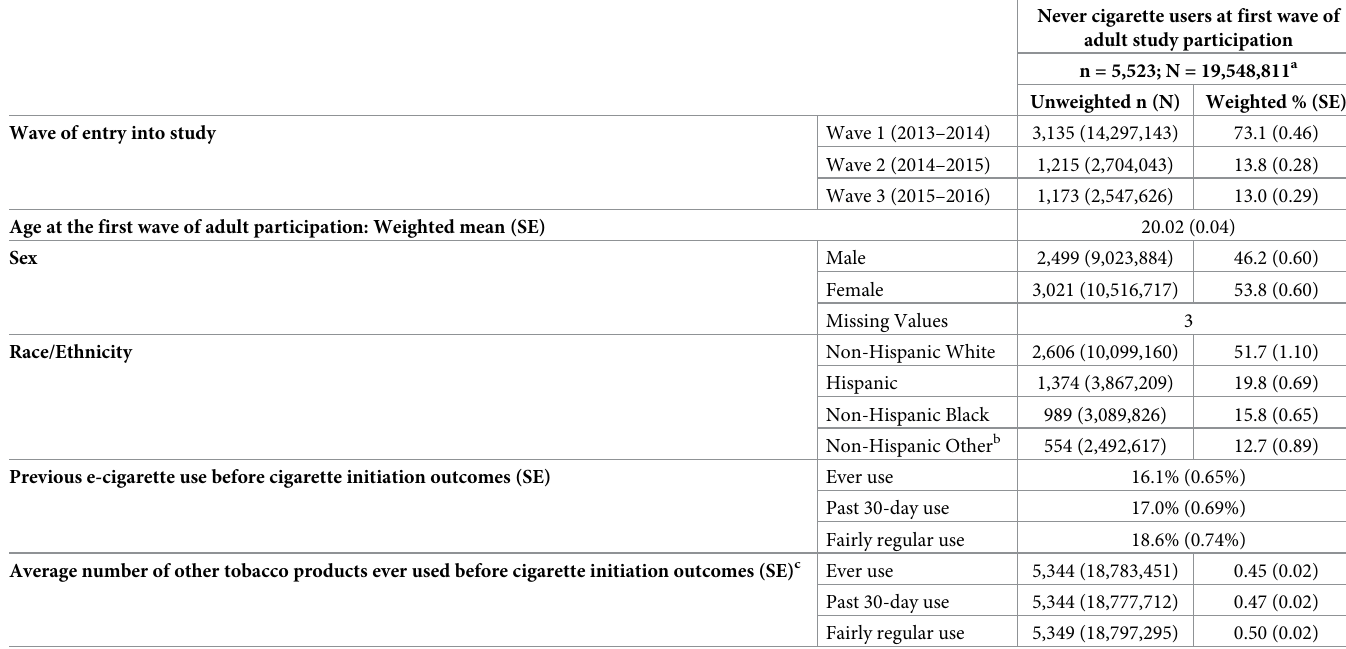
Table 1. Demographic characteristics of PATH young adult (ages 18–24 years old) never cigarette users at their first wave of adult study participation, 2013–2016 �